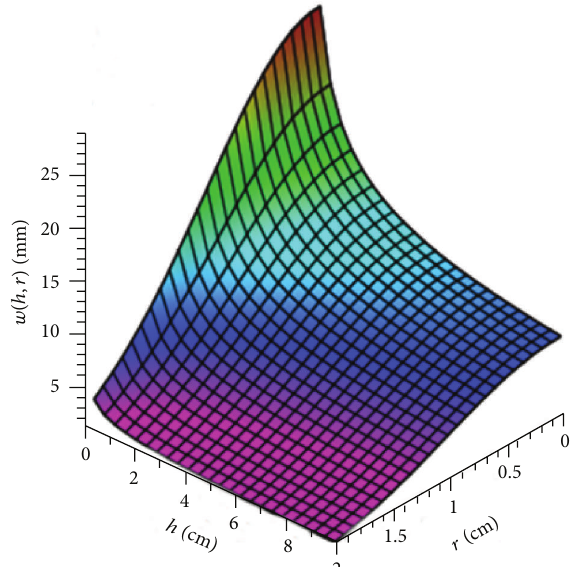
Figure 7: Deflection of the metallic plate 𝑤 in function of the metal thickness ℎ and radial distance 𝑟